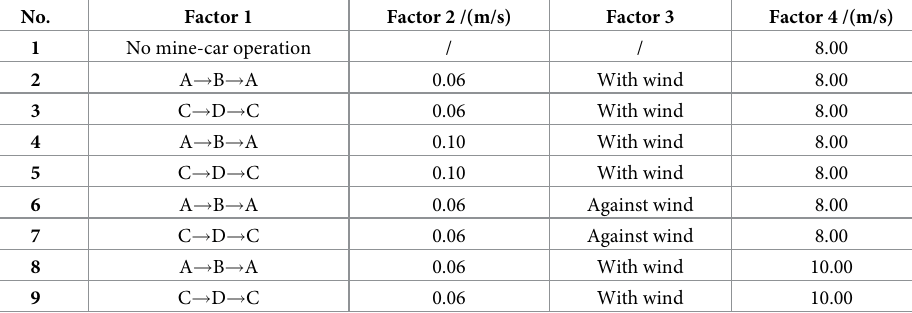
Table 2. Mine-car operating